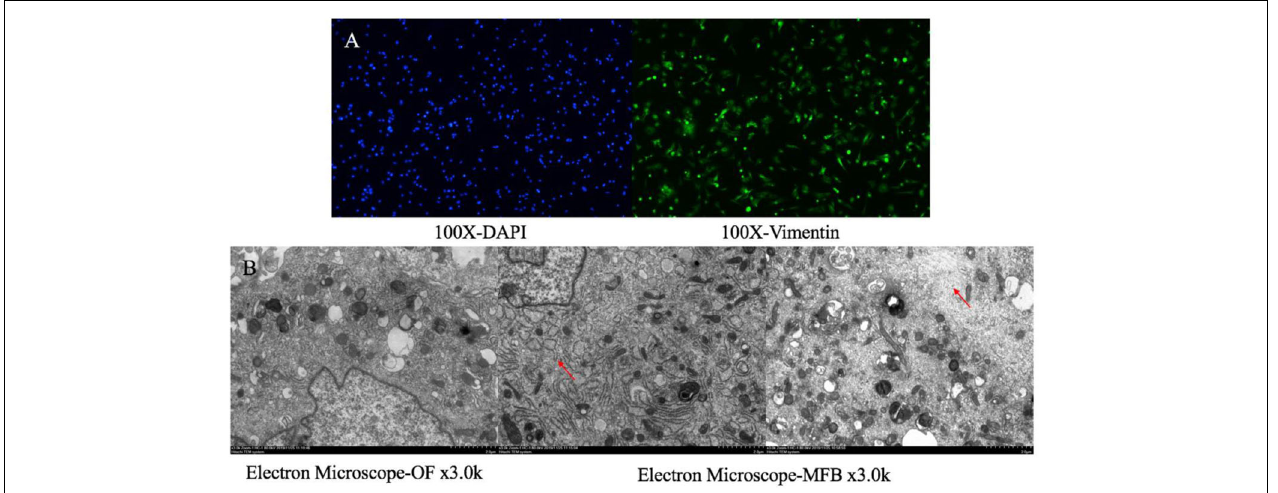
FIGURE 6 | Orbital fibroblasts and myofibroblast. (A) Primary culture orbital fibroblasts for BALB/c mice for IF staining; (B) OF and TGF- β to induce OF for Electron Microscope.